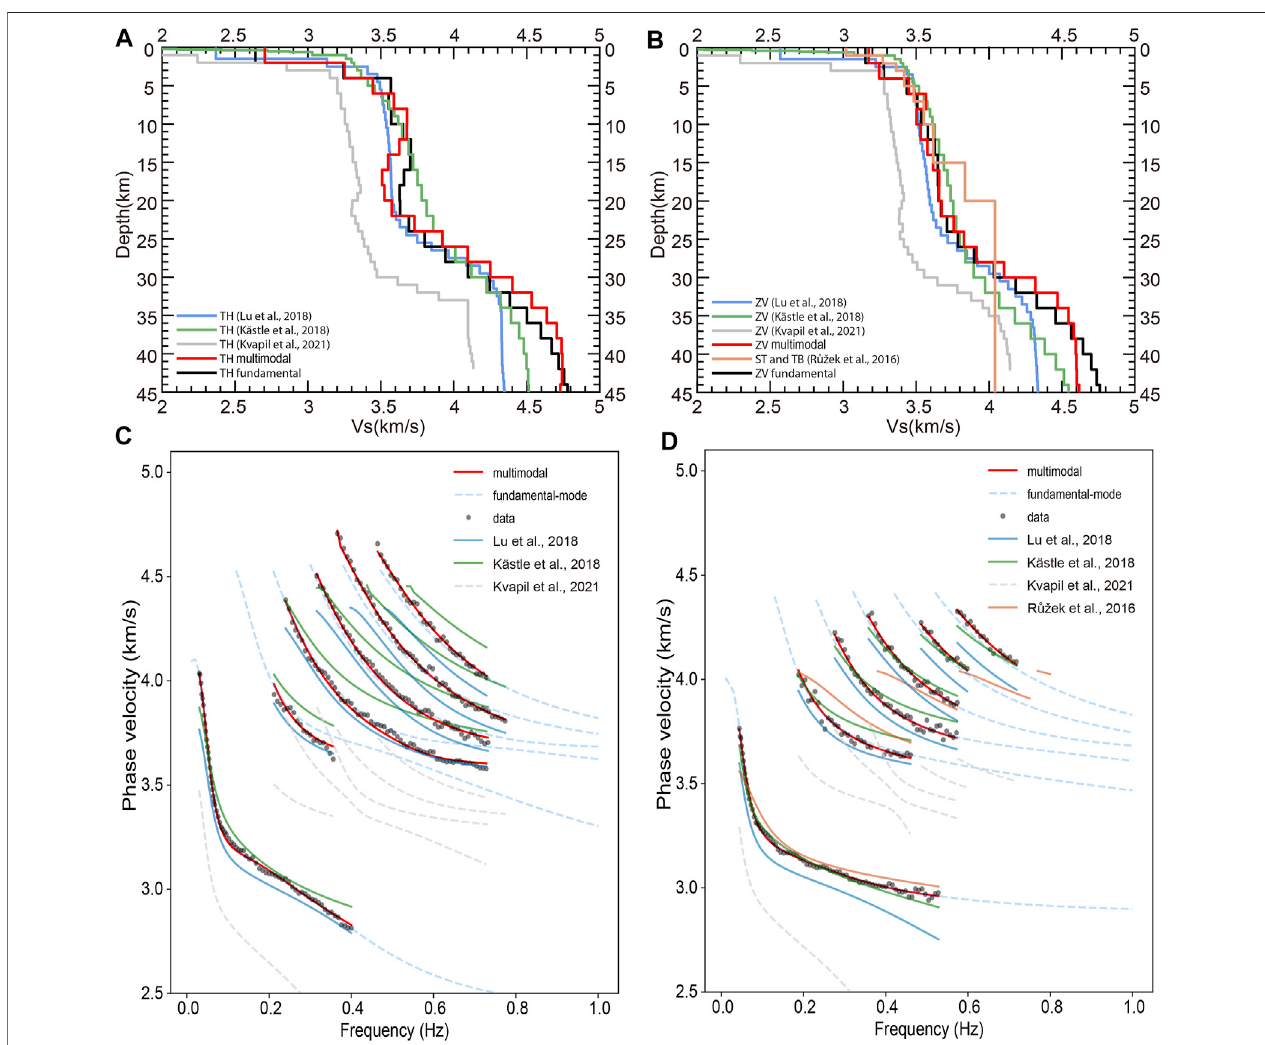
FIGURE 13 | Velocity models of previous studies and their fi tting results with the picked data in the study area. (A) S-wave velocity models for array “ TH ” . Different colorsdenotethedifferentaverage1DS-wavevelocitymodelsbeneaththestationsofarray “ TH ” (Kästleetal.,2018;Luetal.,2018;Kvapiletal.,2021),andtheredsolid line denotes our model obtained from the inversion of multimodal dispersion curves. The black solid line denotes the model obtained from the inversion using only fundamental mode. (B) S-wave velocity models for array “ ZV ” . The yellow line is the average of the 1D models below the ST and TB units in the study area